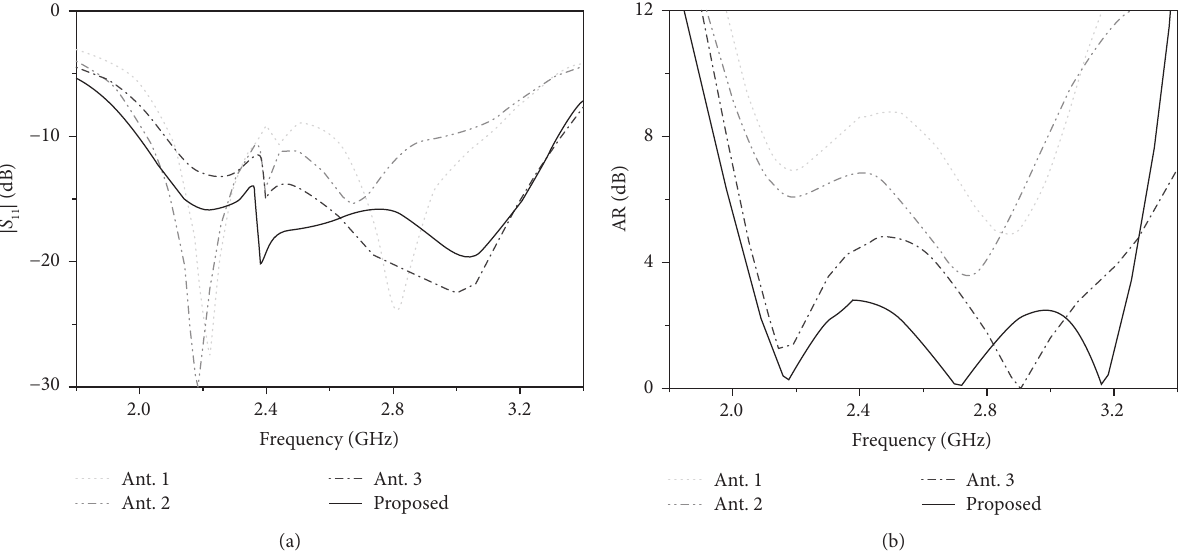
Figure 3: | S 11| and AR curves for different antennas: (a) | S